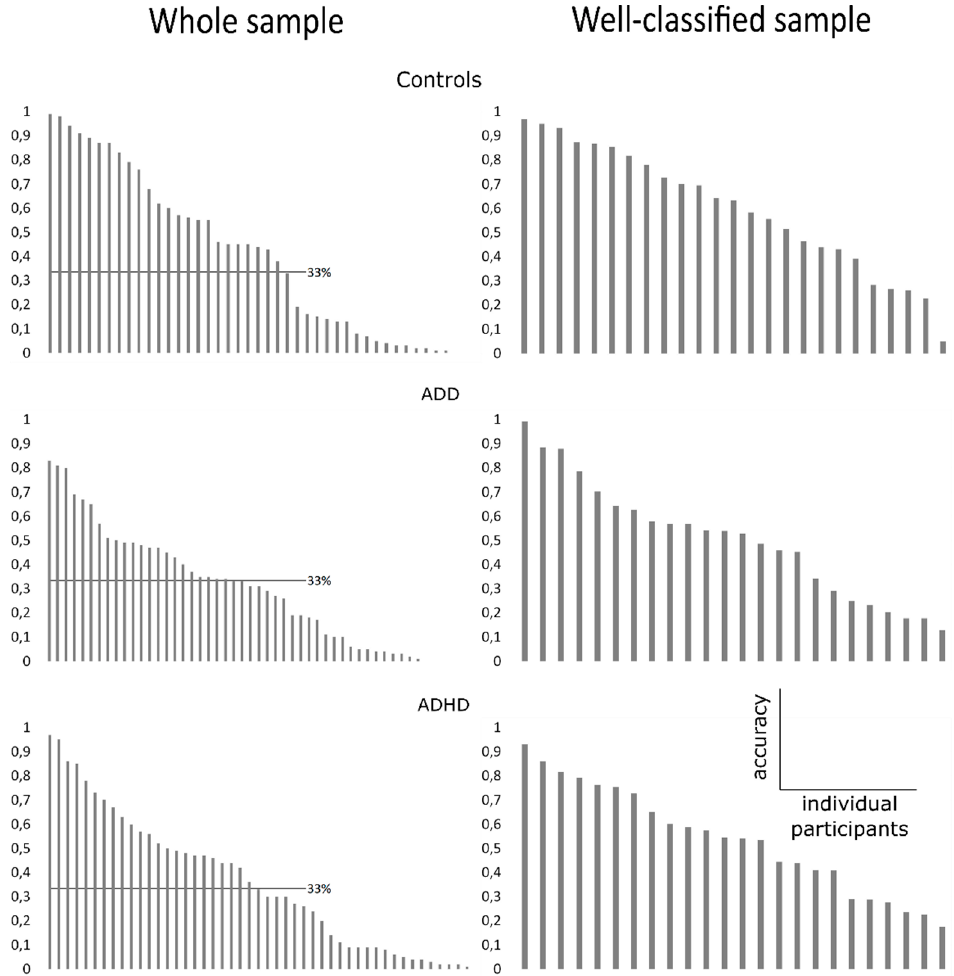
Figure 1. Plots showing distribution of classification accuracy in the whole sample ( A ) and in the well-classified sample ( B ) for all three groups. Y-axis indicates classification accuracy, x-axis indicates the individual participants ranked by classification accuracy (from highest to lowest). In ( A ), the single-trial EEG data recorded during the time estimation was used to classify each individual participant as belonging to the healthy control, the Attention Deficit Disorder (ADD), or the Attention Deficit Hyperactivity Disorder (ADHD) group. To account for potential artifacts and outliers, any participants with a classification accuracy below chance level (33%, as indicated by vertical line) were not included in subsequent analyses. In ( B ), the same analysis of classification accuracy was run a second time. Here, only the single-trial EEG data of participants belonging to the well-classified sample were used. Importantly, the plots show the distribution of classification accuracy.